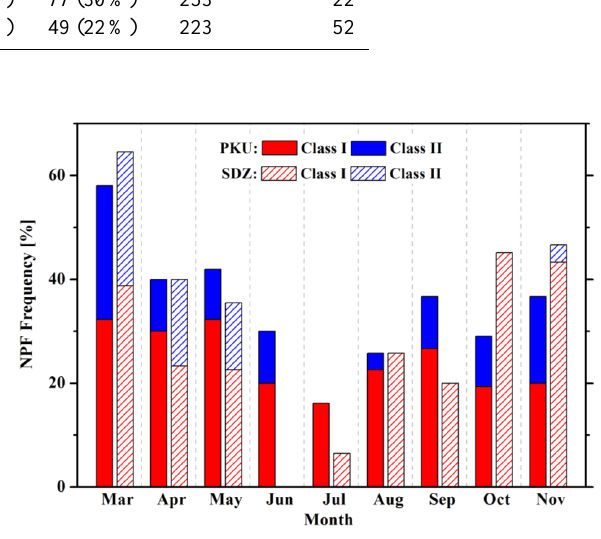
Fig. 1. The frequencies of NPF events versus month at two sites Figure 1 . The frequencies of NPF events versus month at two sites during the whole measurement period. 837 during the whole measurement 838